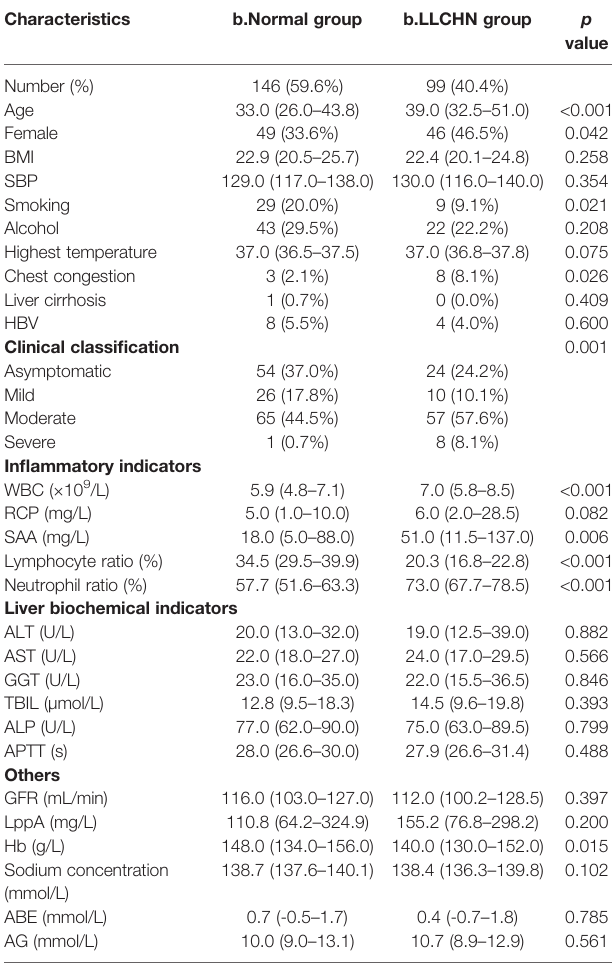
TABLE 1 | Characteristics of 245 COVID-19 patients within 3 days of